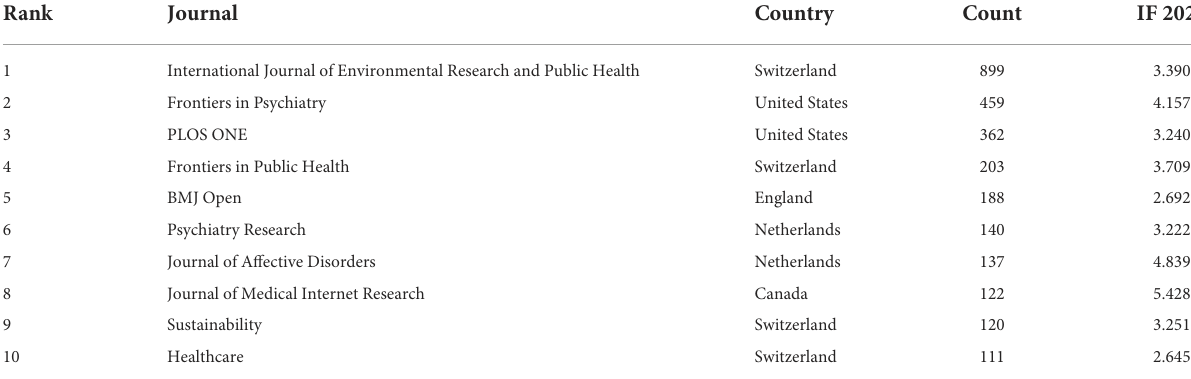
TABLE 1 The top 10 journals that published articles on mental health research related to COVID-19.